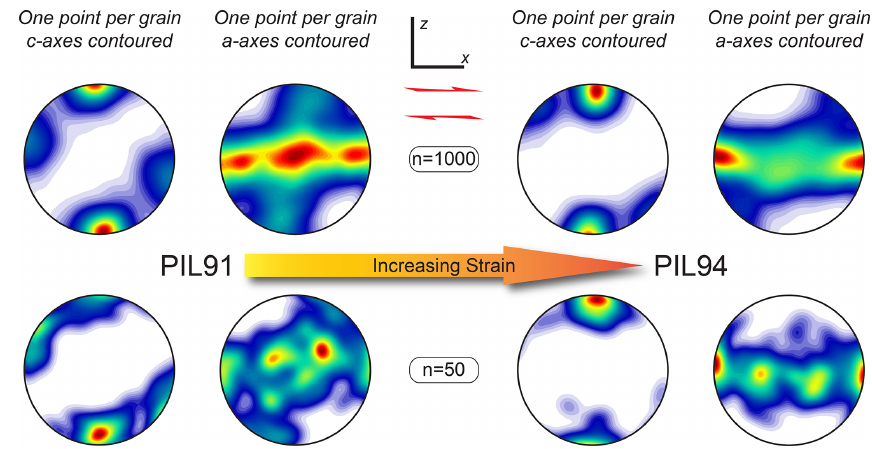
Figure 9. Samples PIL91 ( γ = 0 . 62) and PIL94 ( γ = 1 . 5) from Qi et al. (2019), displaying the full dataset and a typical subset of randomly resampled data. Both of these samples were deformed at − 5 ◦ C at 20MPa confining pressure in a cryogenic gas medium apparatus under constant axial-displacement rates and terminated at different shear strains. In all cases, the pole figures are in kinematic coordinates, with x being the shear direction and x – y the shear